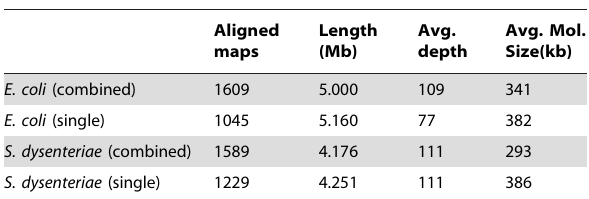
Table 2. Assembly